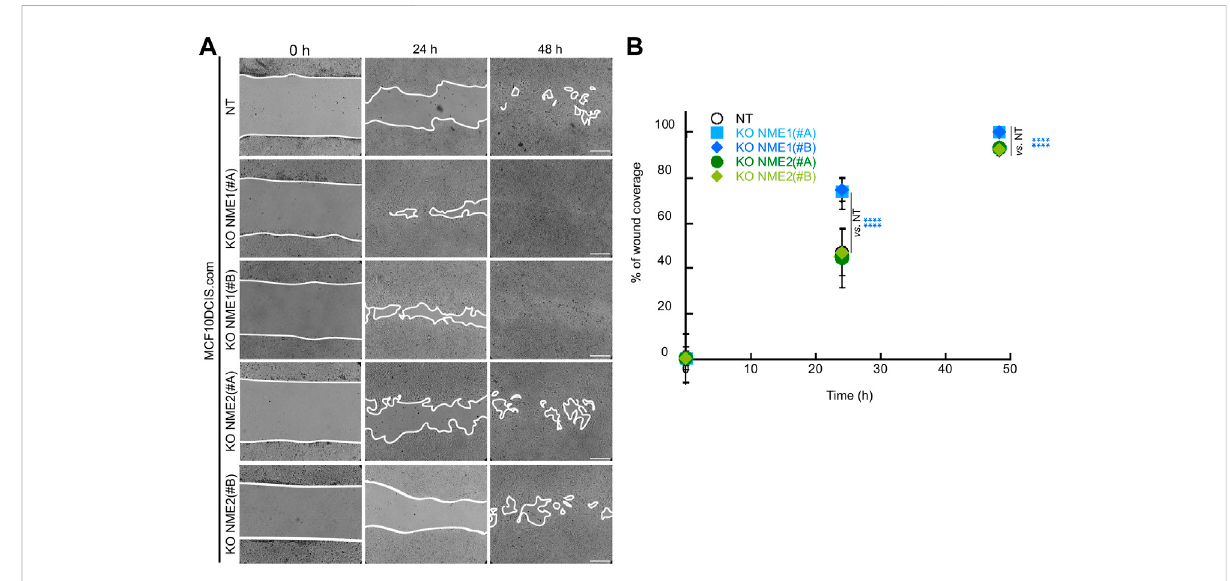
FIGURE 2 Inactivation of NME1 promotes directional migration. (A) Representative light microscopy images of the wound healing assay of MCF10DCIS.comcellsinwhichNME1orNME2wasinactivated.Time0representscon fl uentmonolayerwoundsat0 h,andwoundsweremonitored until NME1-ablated cell monolayers became fully closed 48 h after scratching the monolayer. Images are representative of three independent biological replicates. Scale bar: 100 μ m. (B) Quanti fi cation of the area of migration over time shown in (A) . Data show means ± SD of three